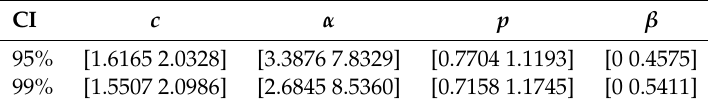
Figure 6. PP, QQ, epdf and ecdf plots of the OGWG distribution for data set 2. Table 8. Confidence intervals of OGWG for data set